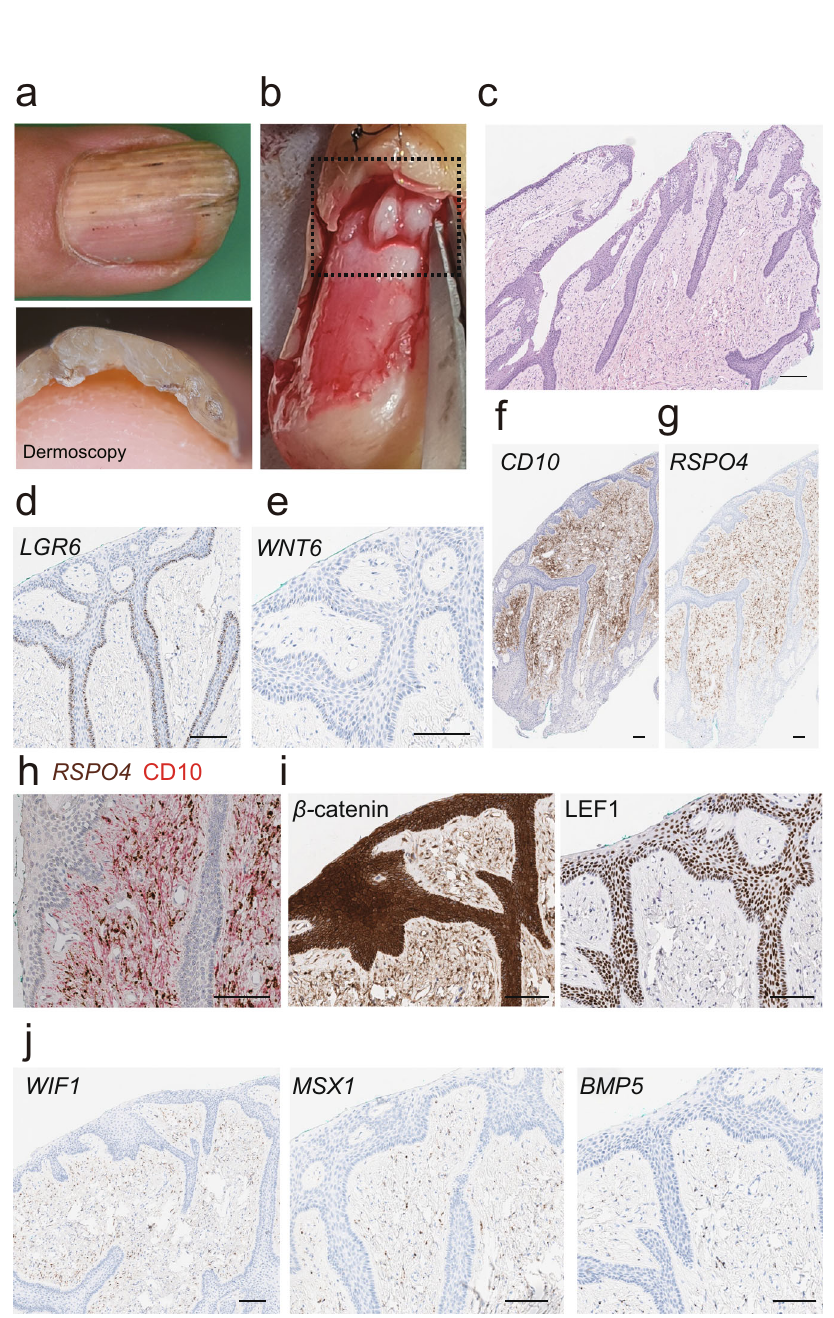
Fig. 5 Clinico-histopathologic fi ndings of onychomatricoma. a Clinical images of onychomatricoma. b Surgical pictures of onychomatricoma. c Representative image of H&E from surgical resection. d , e ISH of LGR6 and WNT6 on onychomatricoma. f IHC of CD10. g ISH of RSPO4 . h Dual RSPO4 ISH and CD10 IHC. i Representative IHC showing expression of β -catenin (left) and LEF1 (right), markers for Wnt/ β -catenin signaling. Cells with nuclear β - catenin staining are found in the epithelial region of onychomatricoma. j ISH of WIF1 , MSX1 , and BMP5 on onychomatricoma. Scale bar = 100 μ m. ISH in situ RNA hybridization, IHC